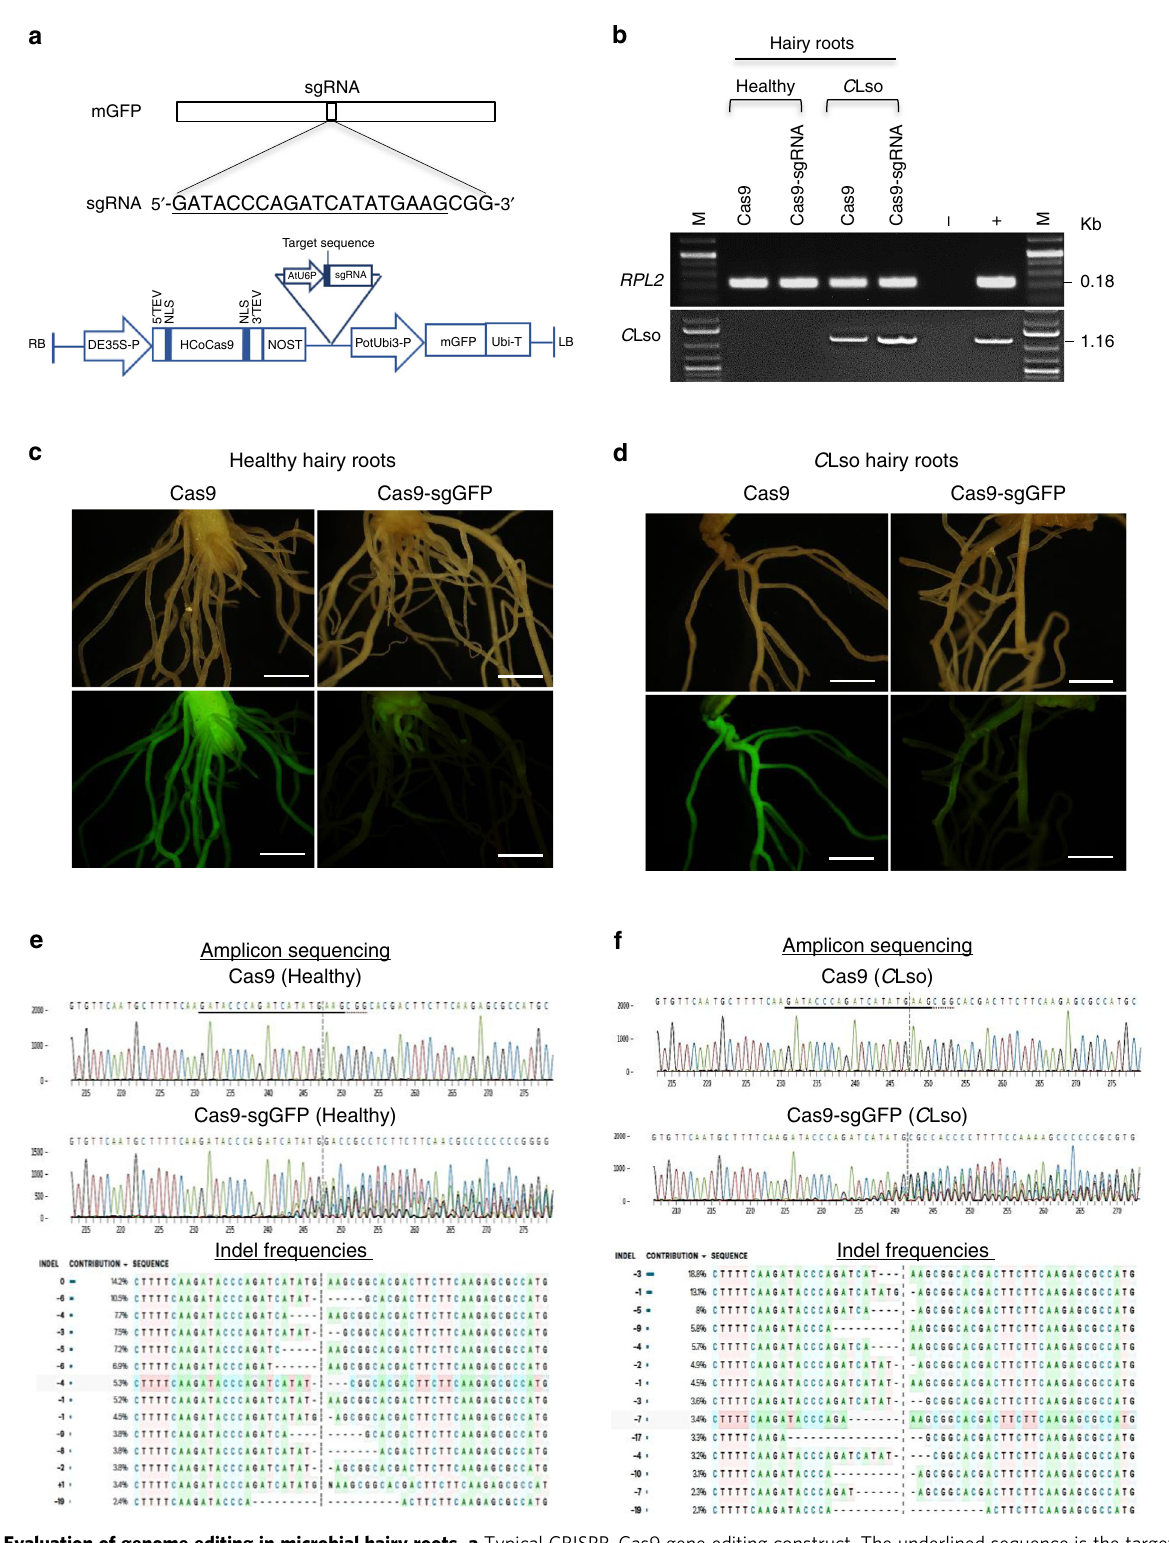
Fig. 3 Evaluation of genome editing in microbial hairy roots. a Typical CRISPR – Cas9 gene editing construct. The underlined sequence is the target DNA site used in the sgRNA. b – d Transformation of Cas9 alone (control) and Cas9 – sgGFP targeting stably expressed GFP transgene in healthy and Candidatus Liberibacter solanacearum ( C Lso) hairy roots. The loss of GFP fl uorescence in Cas9 – sgGFP, but not in Cas9 alone, indicates successful editing of the GFP transgene. Scale bars, 1 cm. The experiment was independently repeated two times, and all attempts of replication were successful. e , f Amplicon sequencing con fi rmed gene editing in the target site (GFP), as indicated by presence of indels in the Cas9 – sgGFP hairy roots, but not in Cas9-alone hairy roots. Frequencies of indels detected were ~86 and 100% in the healthy and C Lso hairy roots, respectively. Uncropped raw agarose gel images used to prepare Supplementary Fig. 3b are presented in Supplementary Fig.